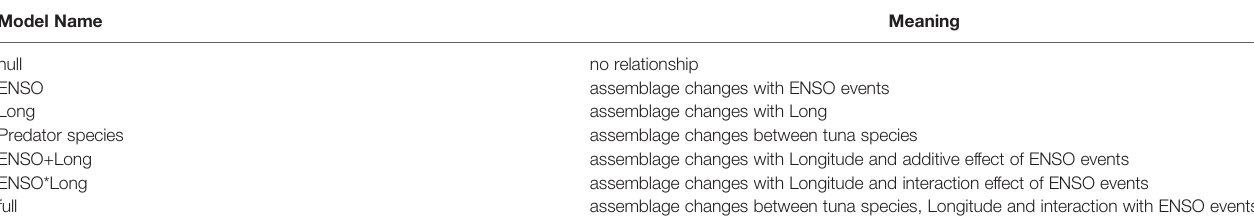
TABLE 2 | Candidate model set used to analyse assemblage changes in gut microbiome (Bacteria) and stomach content (Actinopterygii, Cephalopoda and Crustacea) of tuna species captured in the Paci fi c during El Niño Southern Oscillation